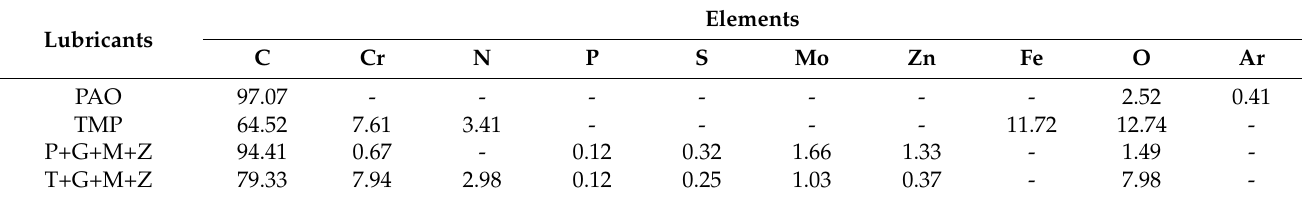
Table 5. Elemental atomic percentage found on a-C:H-coated tappets post-cylinder head testing under various conditions in combination with a-C:H-coated camlobes with TMP-based and PAO-based lubricants. Lubricants